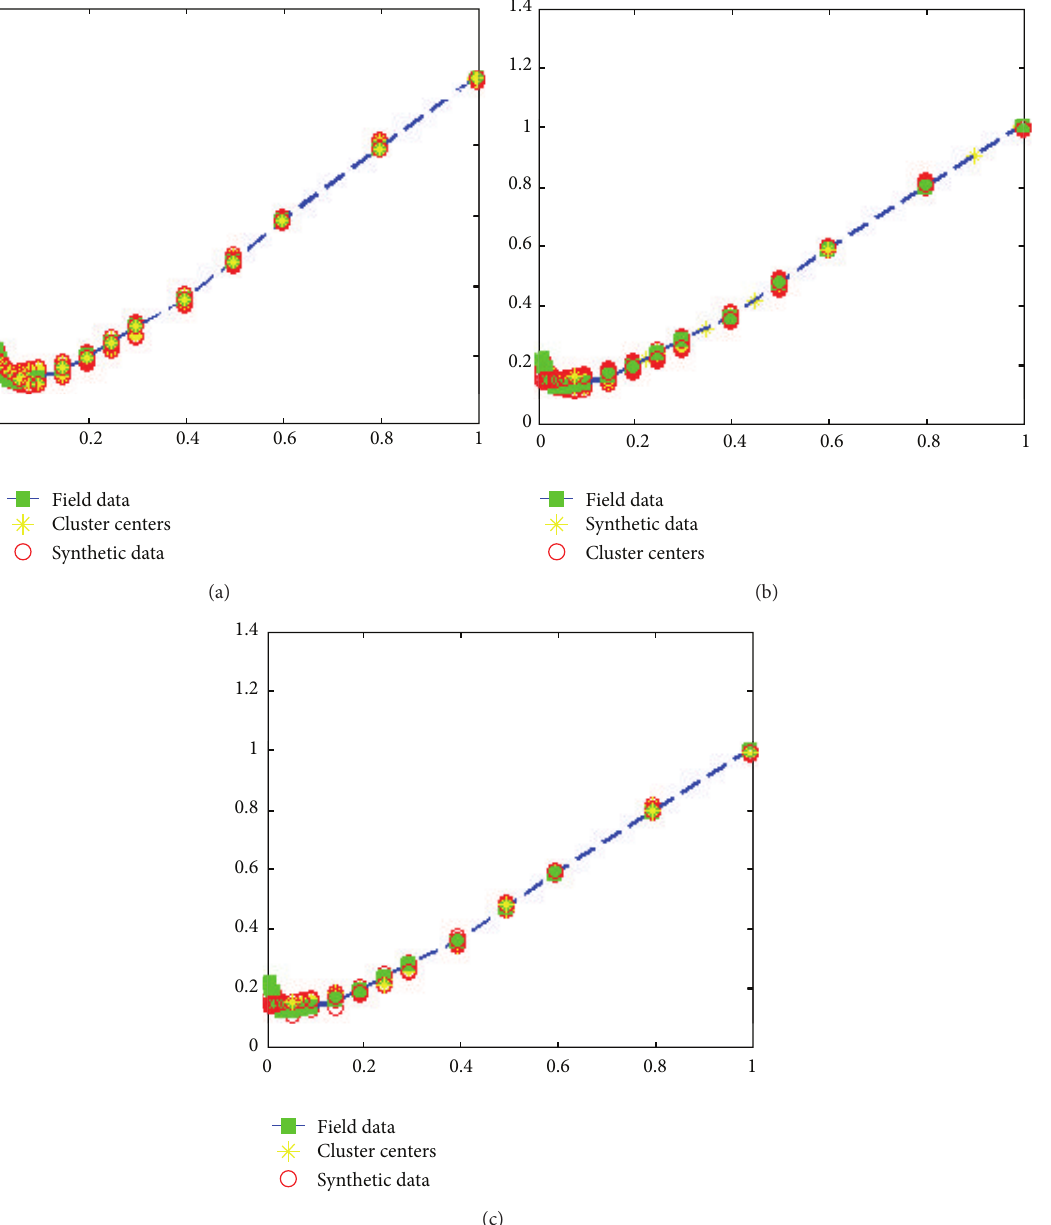
Figure 4: Formation of fuzzy cluster centers while interpreting data 1: (a) fuzzy 𝐶 -means clustering, (b) fuzzy 𝐾 -means clustering, and (c) fuzzy subtractive